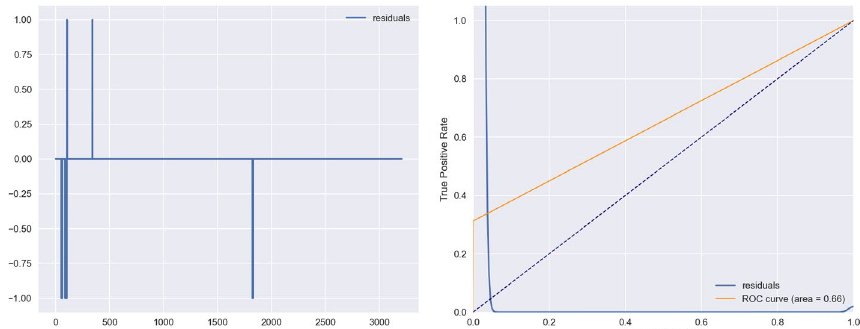
Fig. 8 Results of applying TabNet to D20 only. Left: residual sequence with original timed order. Right: ROC curve and residual distribution